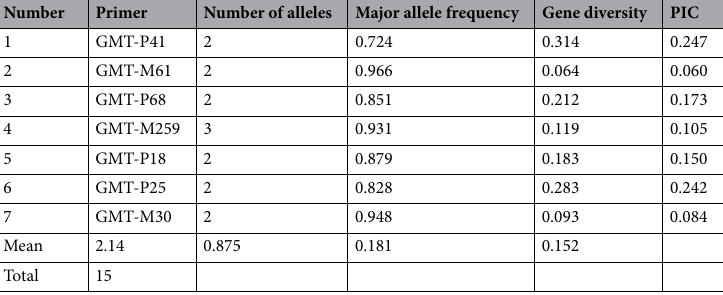
Table 6. Allele number, polymorphic allele number, polymorphism percentage and PIC values of iBPS markers. PIC Polymorphic information